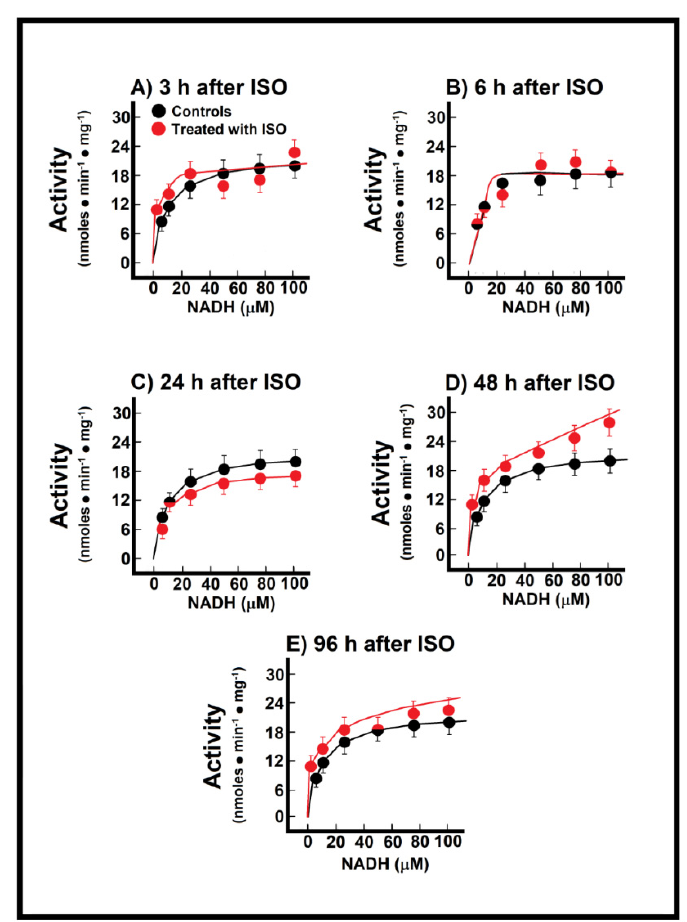
Figure 4. Temporal course of endogenous NADH oxidation at 3 h (Panel ( A )), 12 h (Panel ( B )), 24 h (Panel ( C )), 48 h (Panel ( D )) and 96 h (Panel ( E )) after ISO treatment. Changes of endogenous NADH oxidation during induction of myocardial infarction. Results are expressed as mean ± S.E. of three control animals and five rats treated with ISO per experimental point of the kinetics of the reconstituted malate-aspartate shuttle (MAS). Symbols for the experimental groups at the top of panel ( A ).